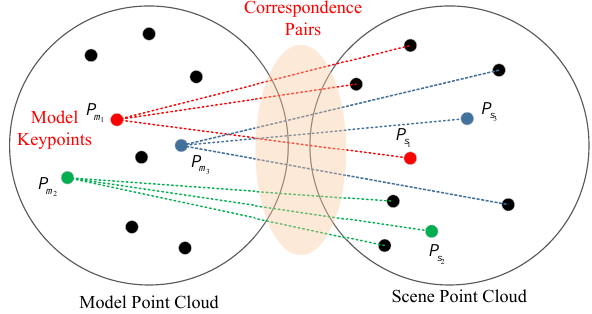
Figure 2. Finding the correspondence pairs in scene point